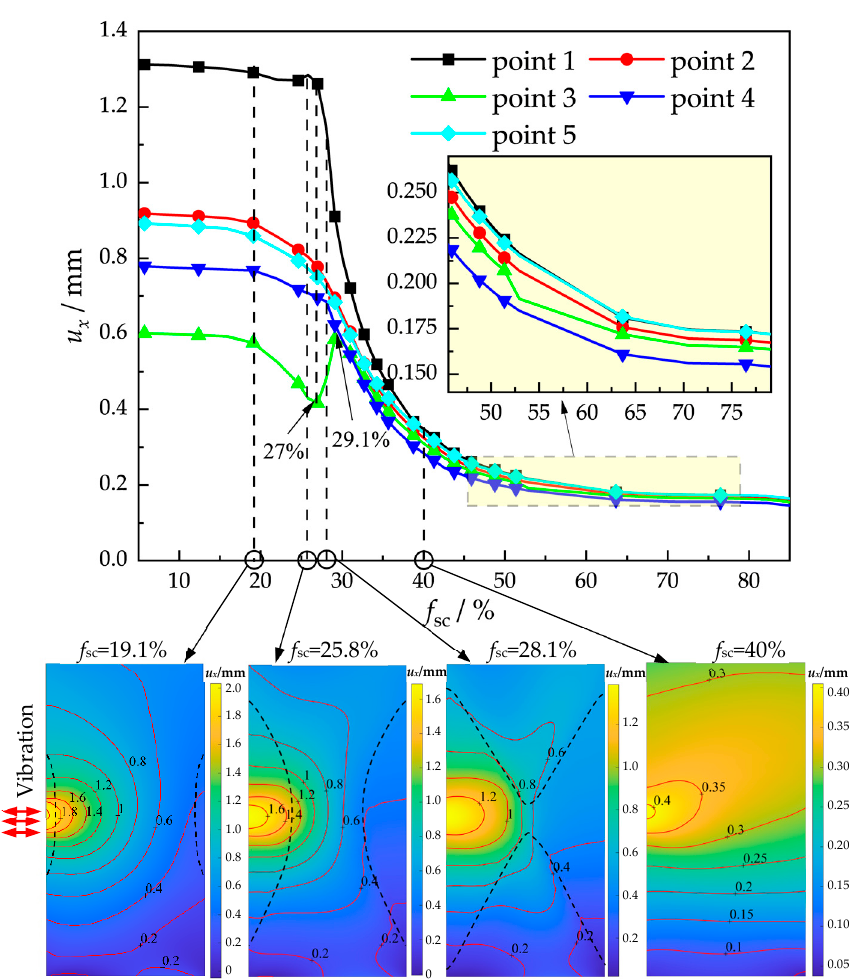
Figure 10. Variation in the displacement amplitude of u x with the solid fraction of the feeding channel f sc .